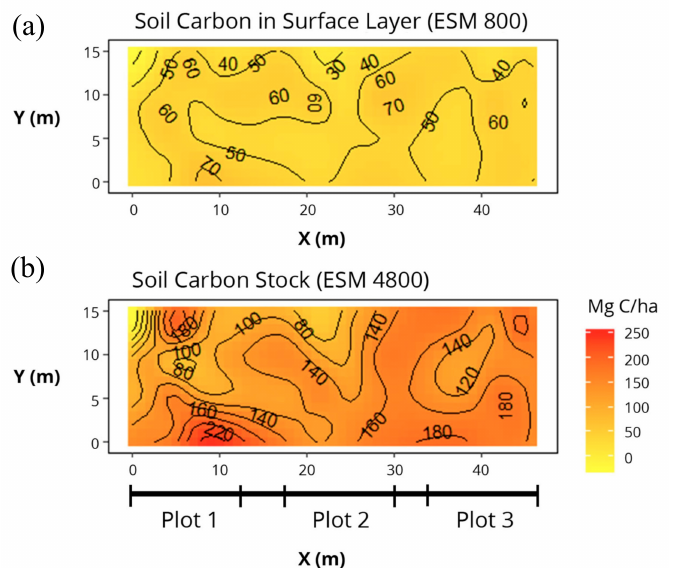
Figure 5. Interpolated soil C stock contour maps by Bayesian kriging of ( a ) surface soil C (Mg C/ha, ESM 800) and ( b ) deep soil C stock (Mg C/ha, ESM 4800). The y-axis is parallel to the slope of the ridge. The aspect of the slope is 117 ◦ for plot 1 and 130 ◦ for plots 2 and